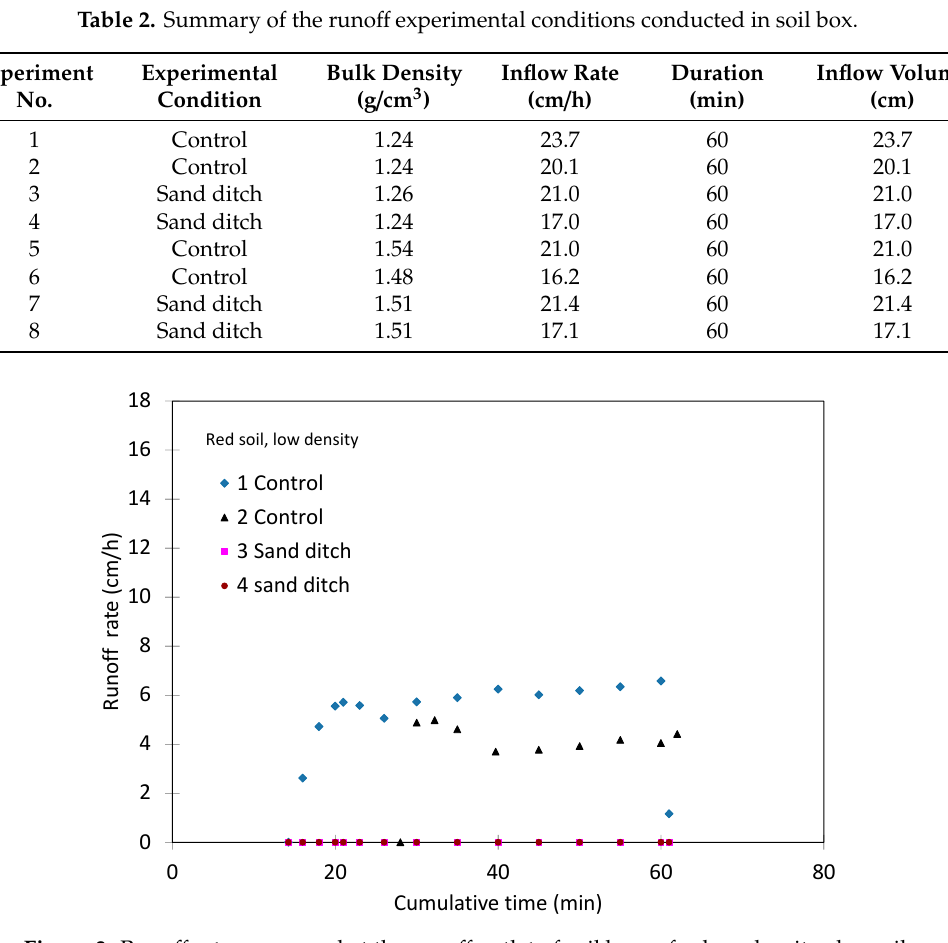
Figure 3. Runo ff rates measured at the runo ff outlet of soil boxes for low-density clay Figure 3. Runoff rates measured at the runoff outlet of soil boxes for low-density clay soil.